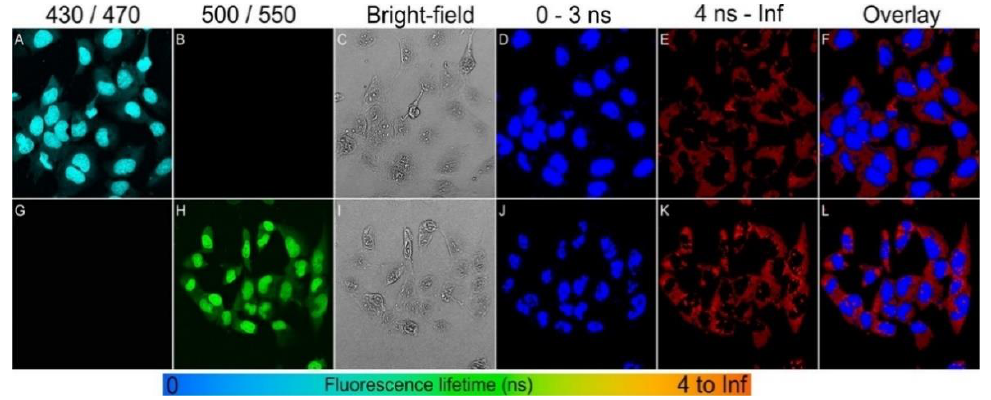
Figure 9. Spectral imaging ( A – C , G – I ) and fluorescence lifetime imaging ( D – F , J – L ) of RL-14 cells separately treated with b-BNQDs/DAPI and g-BNQDs/Sytox green. No emission was detected in panels B and G co-stained with QDs and stains. Fluorescence signals from b-BNQDs and g-BNQDs were resolved using spectrally matched detection ranges as seen in panels A and H. The fluorescence lifetimes were obtained by bi-exponential fitting and mapped to a false-color scale from 0 ns (blue) to >4 ns (red). The resulting false-color shows the difference between signals originating from BNQDs (panels D and J) and organic dyes ( E , K ). Reproduced from [45] with permission from Copyright © 2018 American Chemical Society.